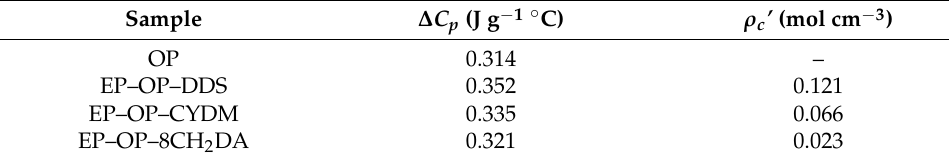
Figure 10. DSC curves of the S–IPNs before and after 500 h of UV irradiation. Table 2. Absolute heat capacities and crosslinking